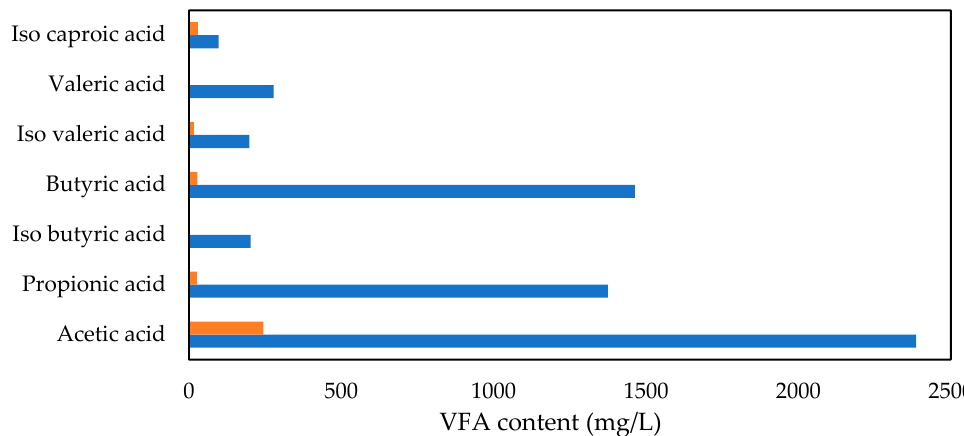
Figure 6. Individual VFAs (C2–C6) concentration in fed (affluent -blue bars-) and digestate (effluent -orange bars-).